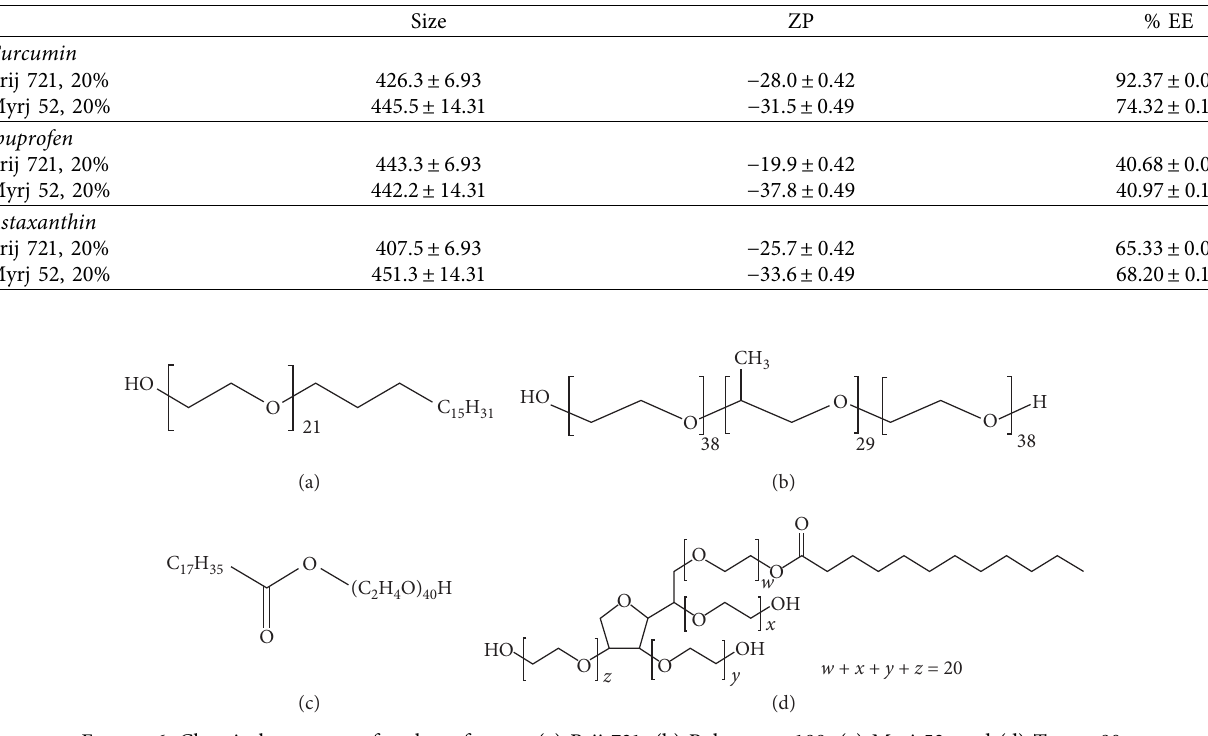
Figure 6: Chemical structure of each surfactant. (a) Brij 721, (b) Poloxamer 188, (c) Myrj 52, and (d) Tween